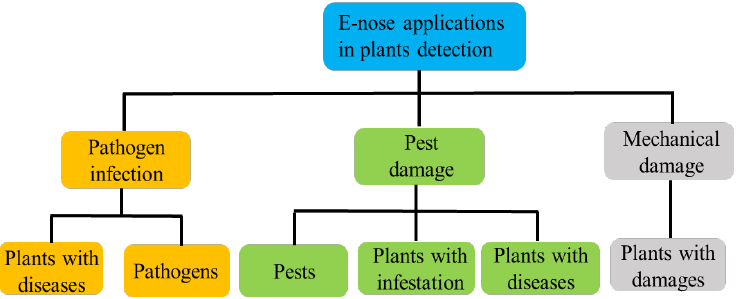
Figure 4 The applications of E-nose in plants disease detection. Figure 4. The applications of E-nose in plants disease